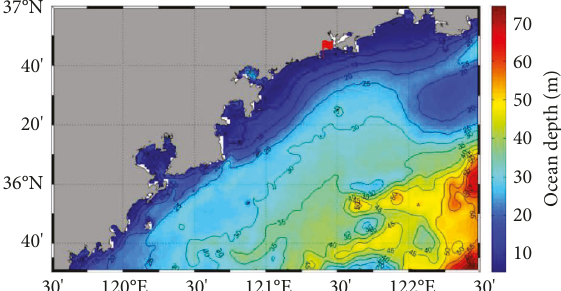
Figure 1: The location of Haiyang nuclear power